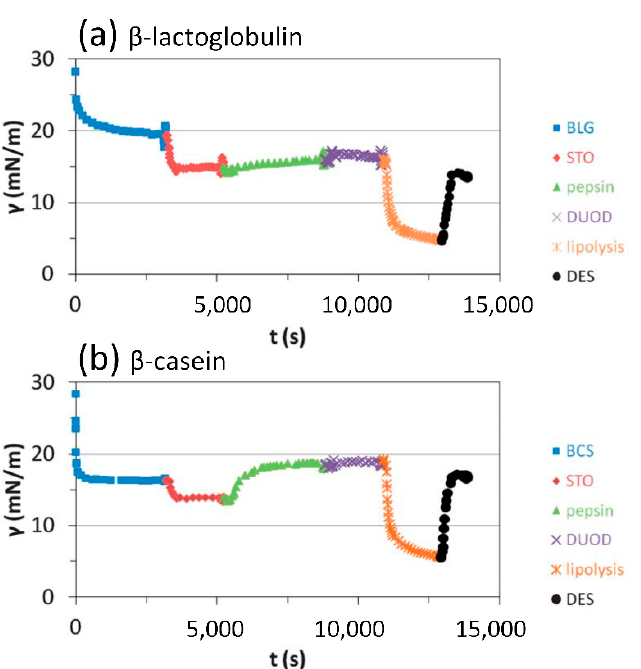
Figure 12. Mimicking the in vitro digestion at the olive oil–water interface with initially adsorbed layers of β -lactoglobulin ( a ) and β -casein ( b ); the gastric buffer (STO), pepsin, duodenal solution (DUOD), lipase and bile salt solution (lipolysis), and duodenal solution (DES) are exchanged into the droplet sequentially (reprinted with permission from [106]).